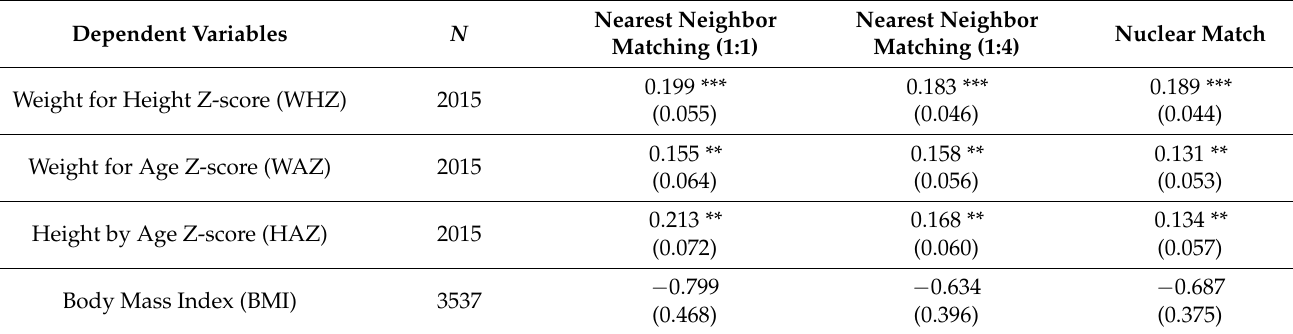
Table 2. Propensity Score Matching (PSM) estimates of the Urban and Rural Resident Basic Medical Insurance (URRBMI)